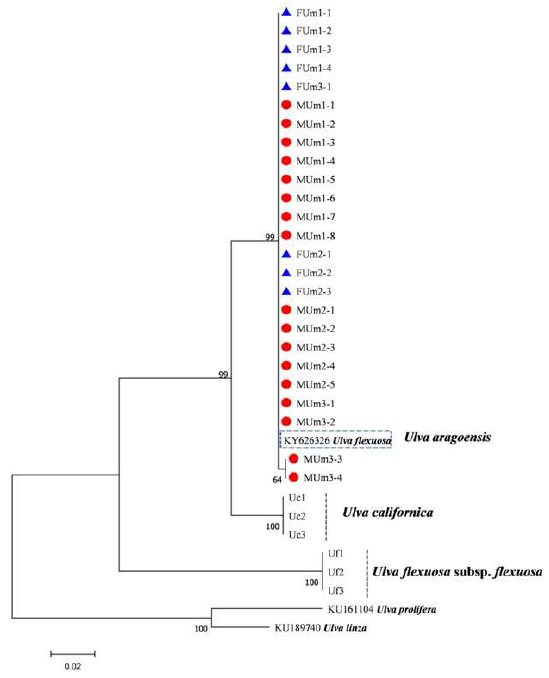
Figure 12. Maximum likelihood tree constructed from the analysis of rps2- trn L gene sequences of U. aragoensis samples and those downloaded from GenBank.